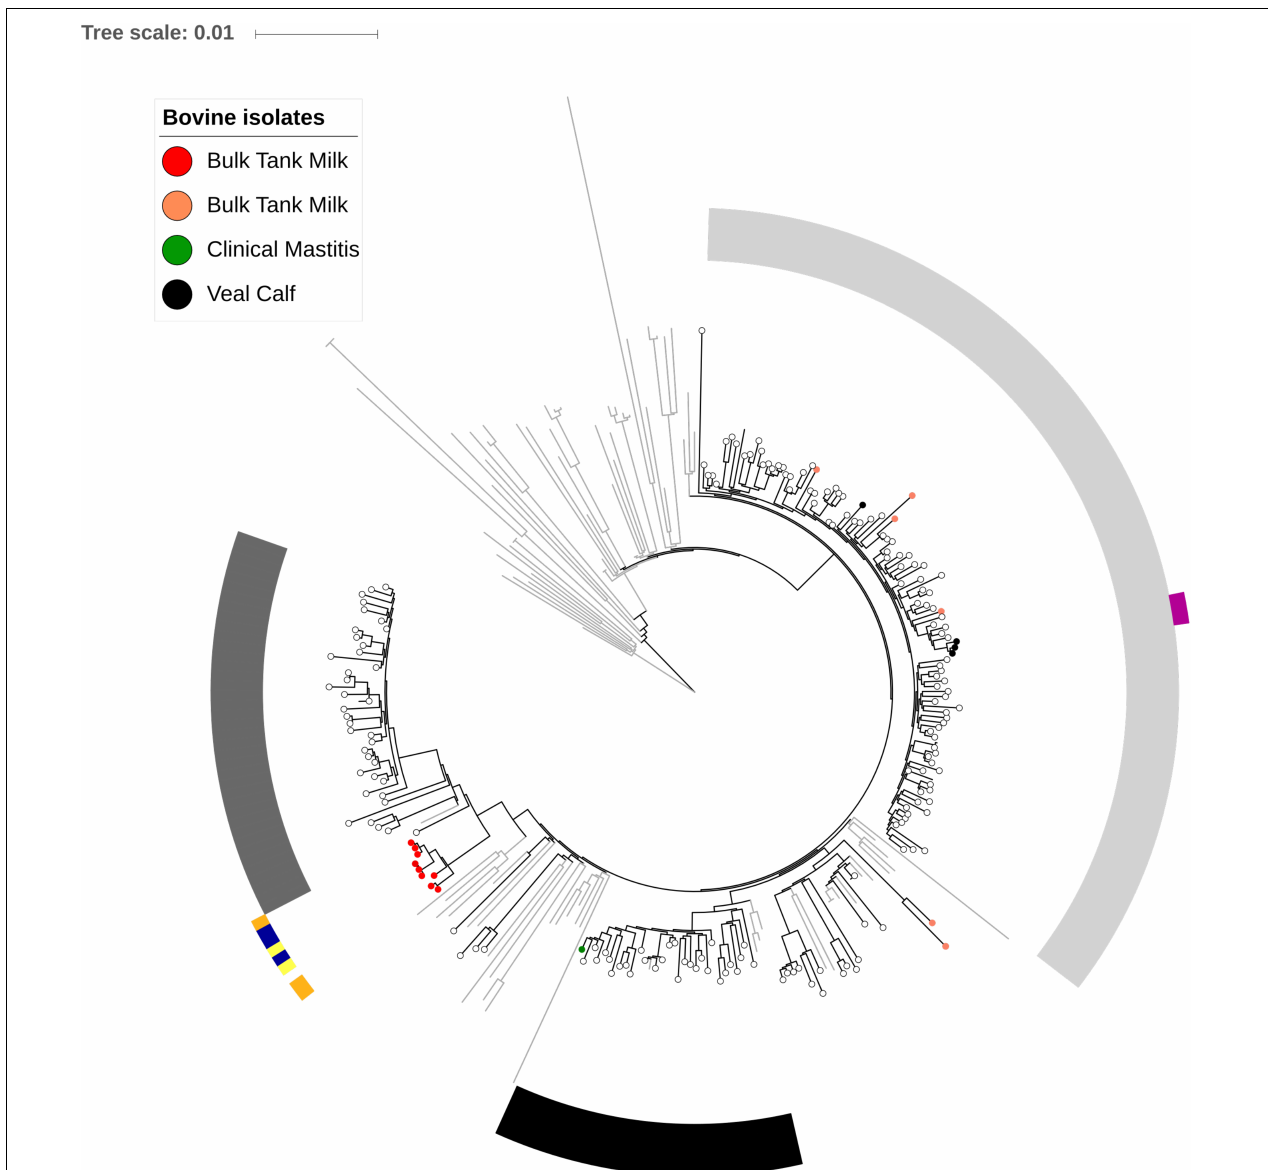
FIGURE 1 | Phylogenetic relationship of LA-MRSA CC398 from bulk tank milk, veal calves, pigs, and from a worldwide reference collection. The phylogeny includes 20 LA-MRSA isolates from multiple bovine sources. Bulk tank milk is divided in red dots which correspond to isolates from four farms with a common owner and orange dots correspond to unrelated farms. Isolates collected from the same farm are marked with strips of identical color. Orange, Farm A; blue, Farm B; yellow, Farm C; and purple, Farm L. A total of 183 isolates related to Danish pigs from 2014 (Sieber et al., 2018) are seen as black open circle and 89 international isolates included as reference phylogeny from Price et al. (2012) are seen as gray nodes. Dominating pig lineages are seen in L1 = dark gray, L2 = black, and L3 = light gray strips. The tree has been rooted according to Price et al.